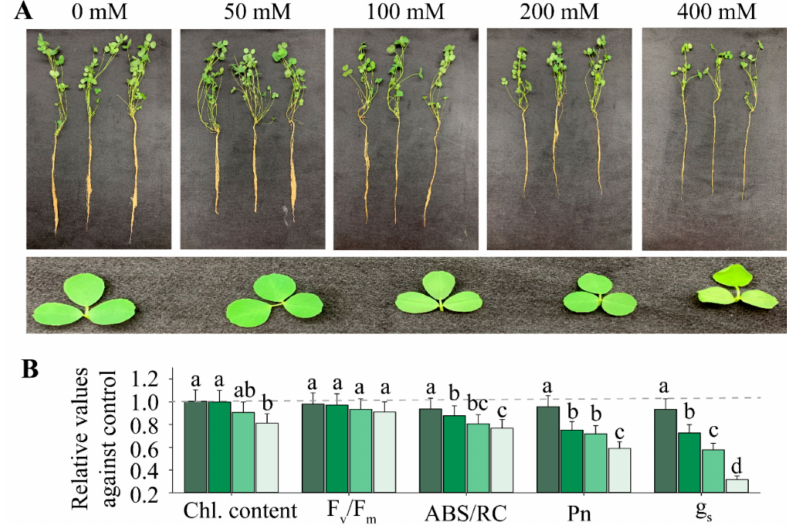
Figure 1. Performance of alfalfa seedlings exposed to di ff erent salt concentrations ranging from 0 to 400 mM for 14 d. ( A ) Plants and leaf images of alfalfa exposed to di ff erent NaCl concentrations